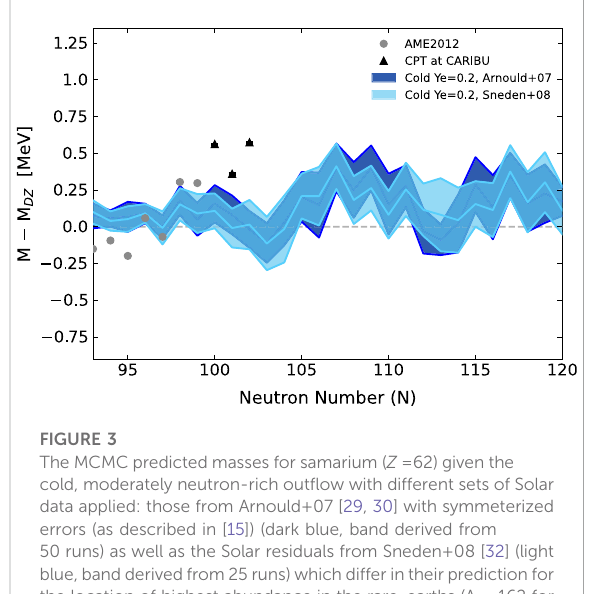
The MCMC predicted masses for samarium ( Z =62) given the cold, moderately neutron-rich out fl ow with different sets of Solar data applied: those from Arnould+07 [29, 30] with symmeterized errors (as described in [15]) (dark blue, band derived from 50 runs) as well as the Solar residuals from Sneden+08 [32] (light blue,band derivedfrom25runs)which differ intheirprediction for the location of highest abundance in the rare-earths (A = 162 for [32] and A = 164 for [29, 30]).